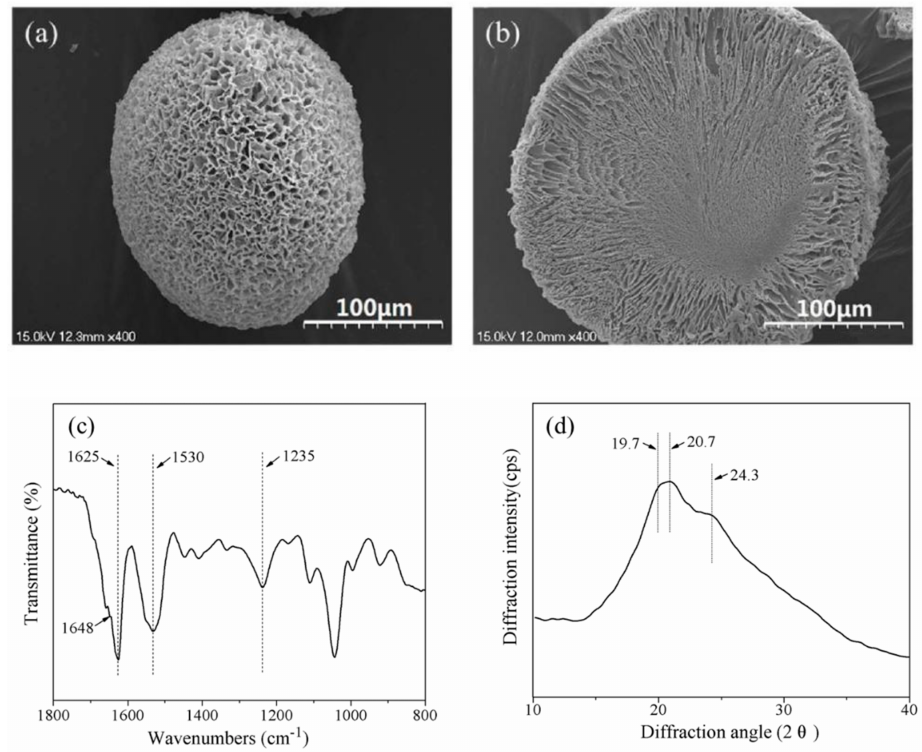
Figure 1. ( a ) The surface SEM image; ( b ) cross section SEM image; ( c ) Fourier transform infrared (FTIR) spectrum and ( d ) X-ray diffraction curve of silk fibroin (SF) microspheres. Scale bars: 100 µ